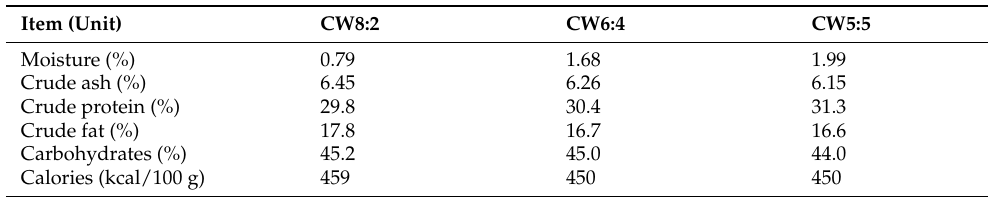
Table 1. The proximate composition and energy values of milk powder adjusted casein to whey proteins ratio (expressed on a dry matter